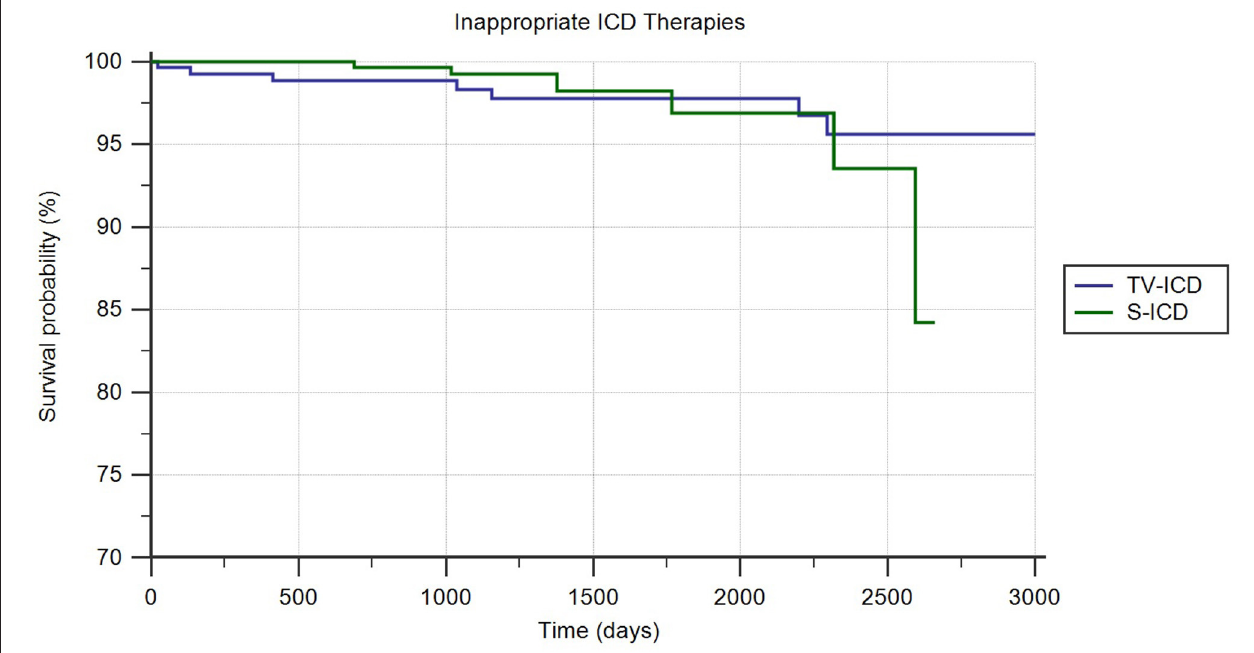
increased risk of ICD-related infections among the TV-ICD group ( log-rank p = 0.02 ) ( Figure 3 ). At Cox multivariate analysis, S-ICD was the only variable significantly associated with a reduction of ICD-related infections ( OR :